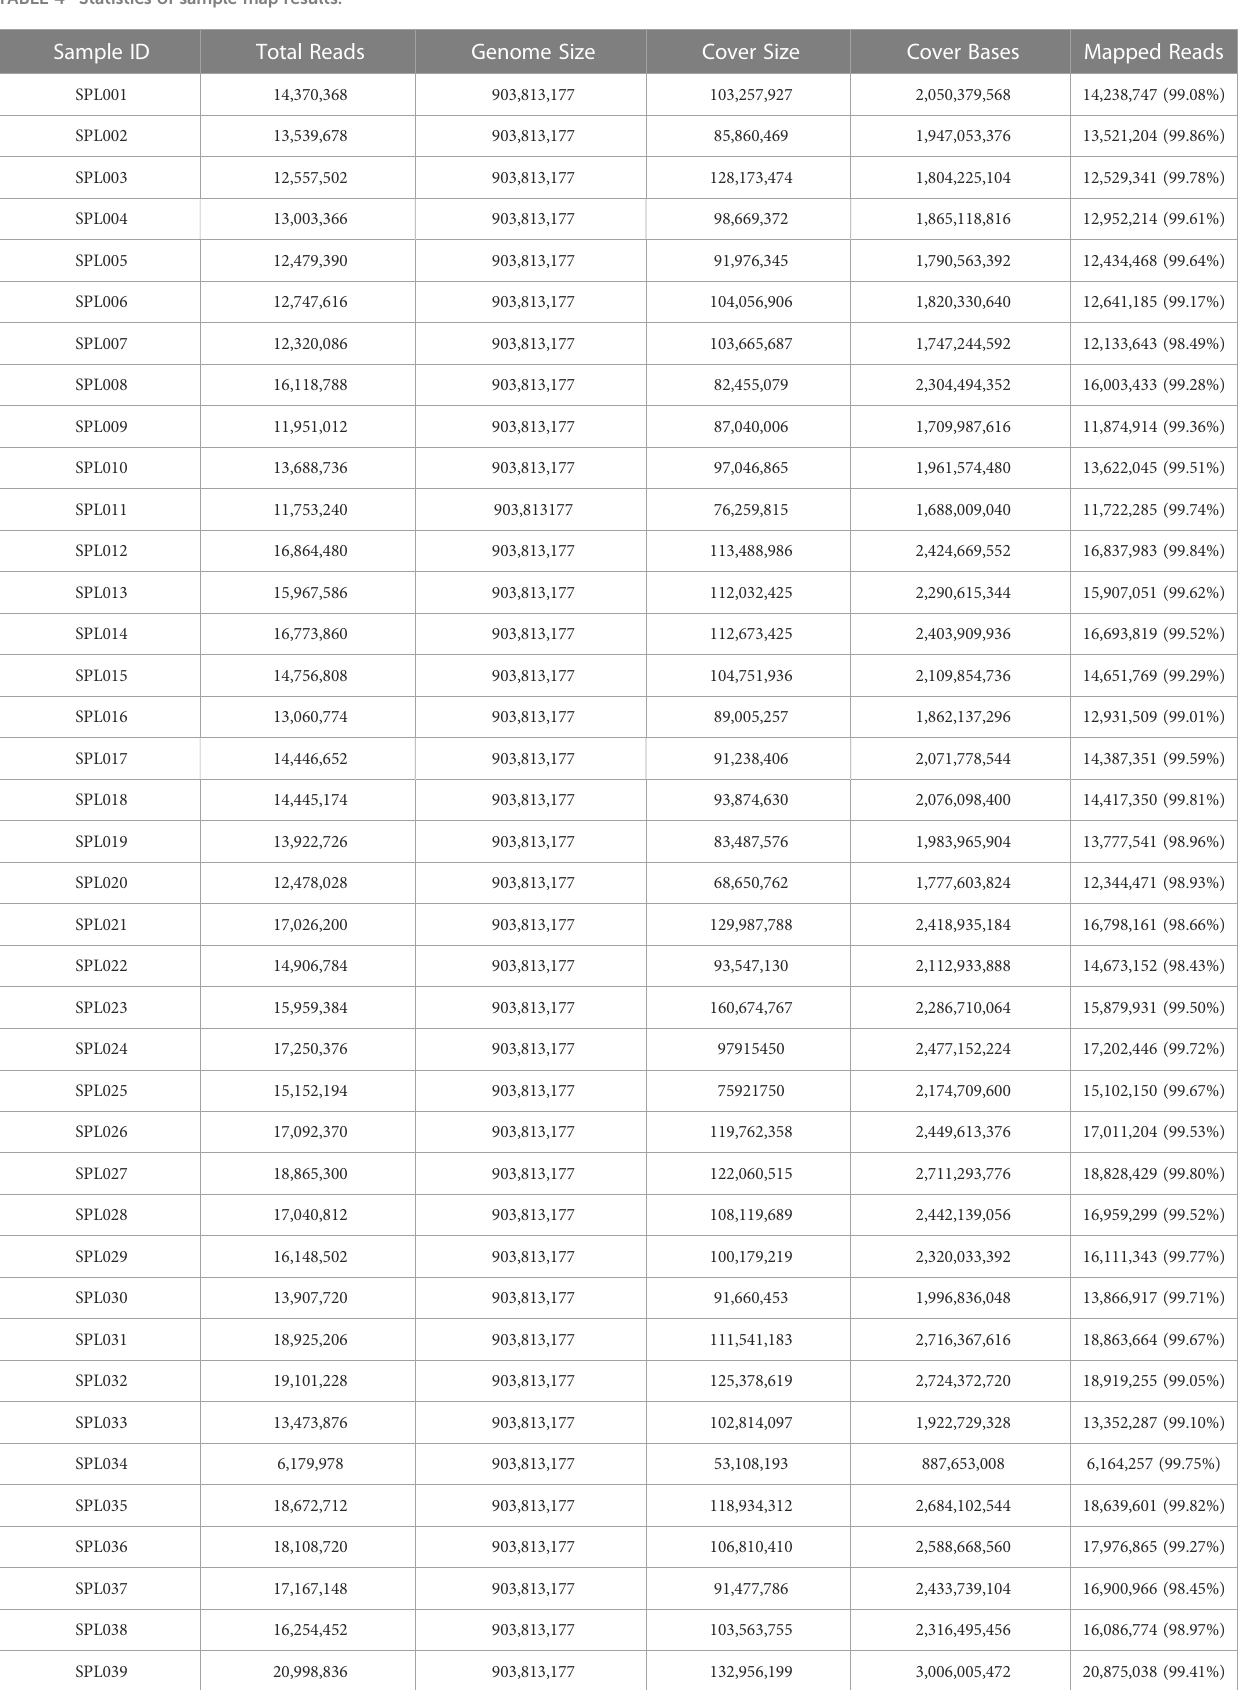
TABLE 4 Statistics of sample map